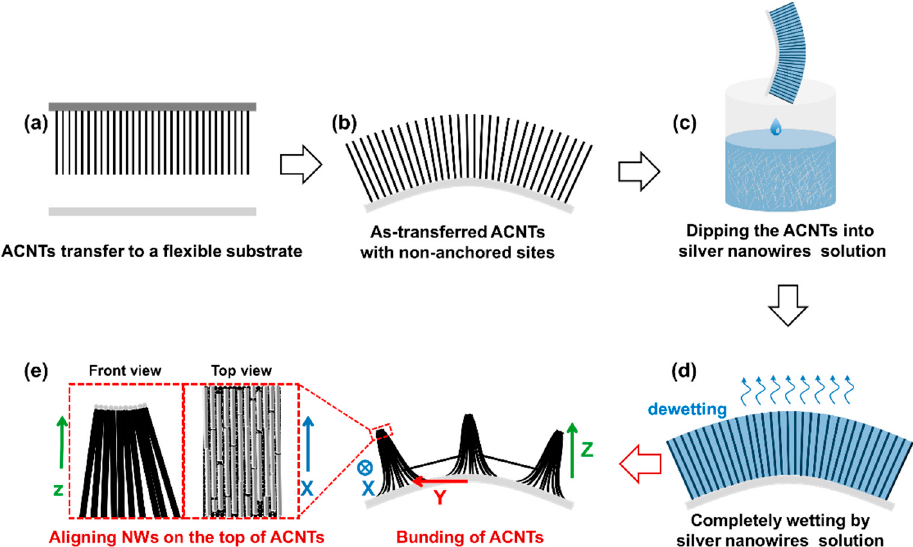
Figure 1. Schematic depiction for the formation process of the multidimensional aligned NWs array. ( a ) ACNTs were transferred from glass substrates to flexible substrates. ( b ) ACNTs on flexible substrates. ( c ) The ACNTs on the flexible substrates were dipped into AgNWs solution. ( d ) The ACNTs underwent a natural evaporation process at ambient condition without conducting any other management. ( e ) As the solution evaporates, aggregating and bundling of the ACNTs happens because of the elastocapillary coalescence, based on which the multidimensional aligned NWs array were developed. The AgNWs on the top layer of the ACNTs were aligned.